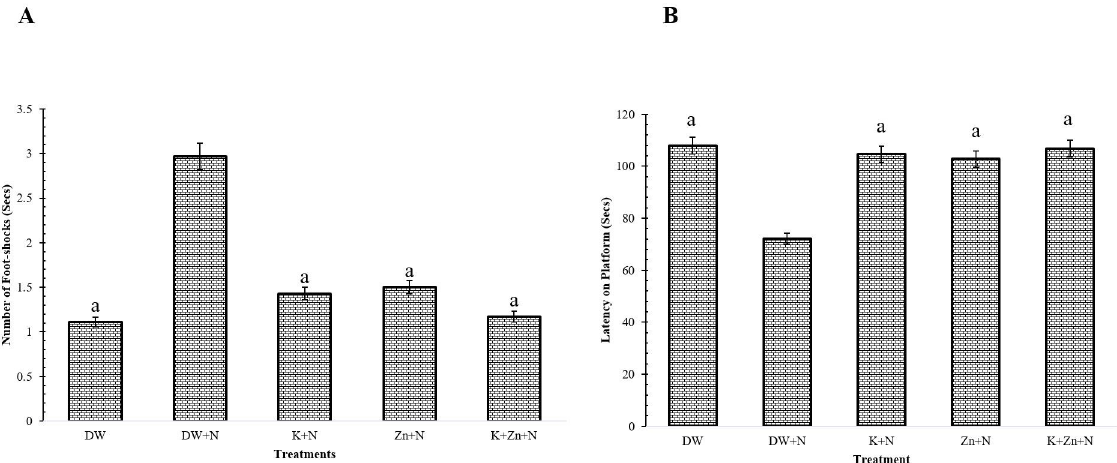
Fig 7. Effect of kaempferol and zinc on learning and memory in Wistar rats exposed to noise stress (Mean ± SEM, n = 6). A) Effect of kaempferol and zinc on learning. B) Effect of kaempferol and zinc on memory. Learning and memory assessment was carried out using the step-down inhibitory avoidance task and the number of times the rat stepped down with all its limbs after receiving an electric shock was used as an index of learning. The maximum learning and memory ability was observed when the rat stayed on the platform for 2 minutes without stepping down. a P < 0.05, b P < 0.01, is significantly different compared to control group (DW+N). DW, Deionized water; K, Kaempferol; Zn, Zinc gluconate; N, Noise.